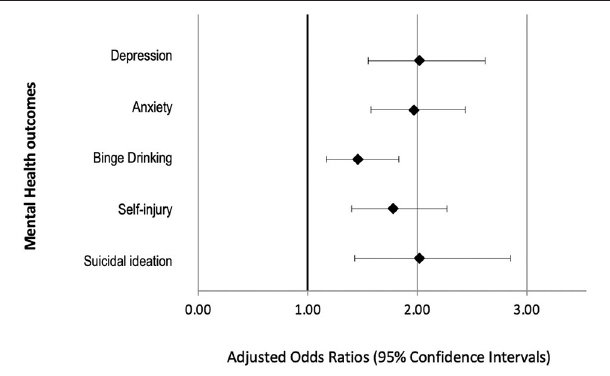
FIGURE 1 | Adjusted odds ratios depicting associations between COVID-19 related racial discrimination and mental health outcomes among Asian American/Pacific Islander students in the Health Minds Study, September–December 2020. All models adjusted for age and